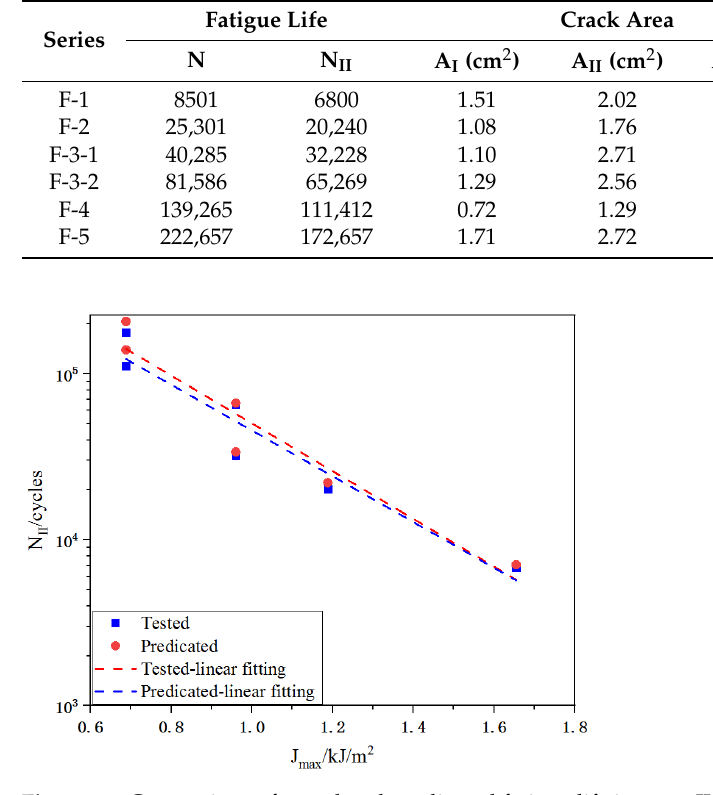
Figure 14. Comparison of tested and predicated fatigue life in stage II [29].